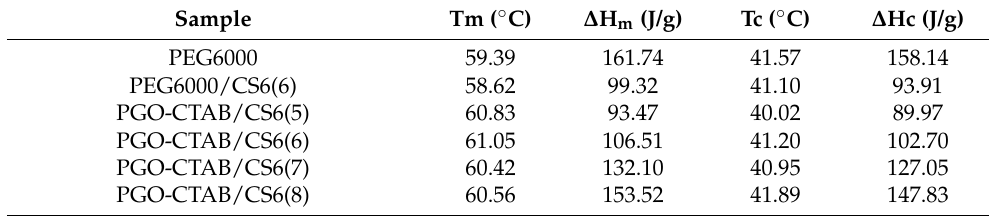
Table 2. Latent heat performance parameters of various